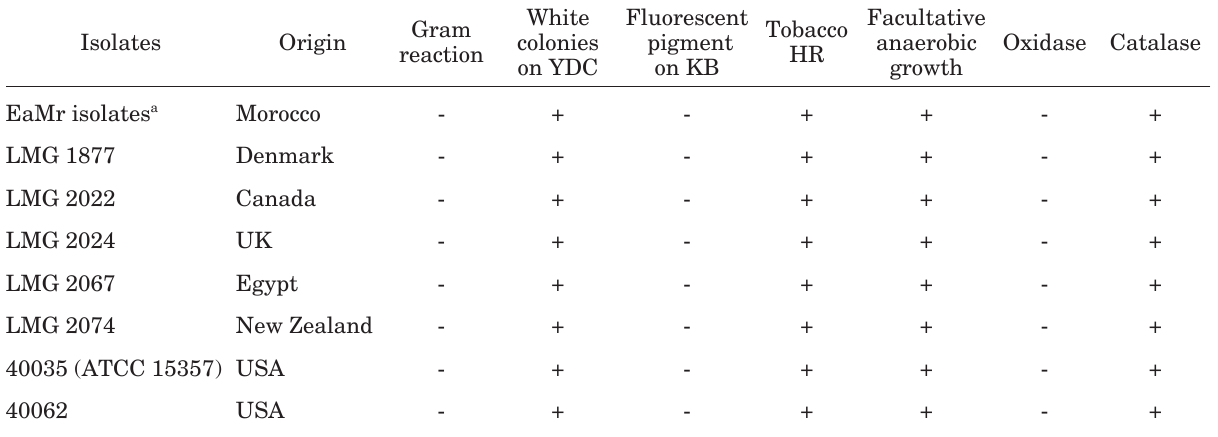
Table 3. Characterization of Moroccan isolates obtained from fi re blight diseased plants from 2006 to 2009 and be- longing to the genus Erwinia .